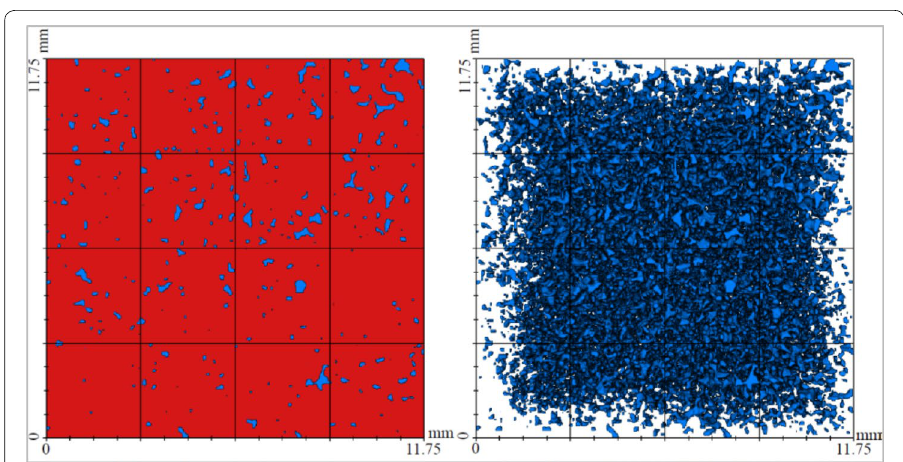
Fig. 9 CT scan of the rock sample: pore spaces are blue while quartz and feldspar are colored red. Left: the grains are visible as red area with blue spots for the pores. Right: visualization of the pores, the matrix is omit- ted in this